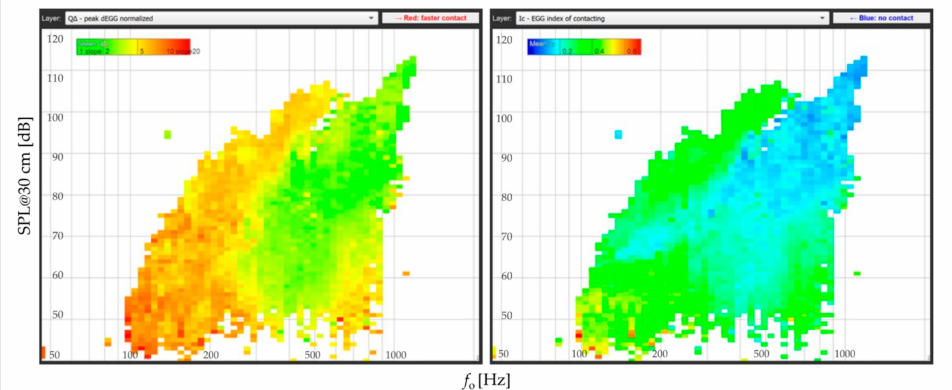
Figure 12. Voice maps of a female amateur singer displayed by FonaDyn software. ( Left panel ): normalized peak derivative ( Q ∆ ), with red and green indicating high and low values, respectively. ( Right panel ): index of contact ( I c ), with red and blue indicating high and low values,